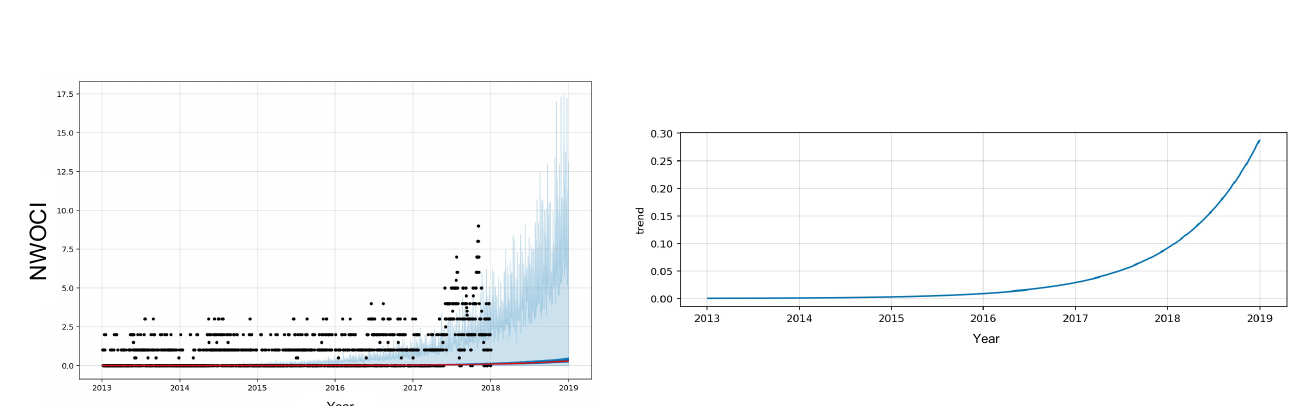
Figure A8. Left : One year forecast (2018 test data) from Prophet-BU Model for Hampden county in MA. N.B: The solid blue line shows the average forecast while the solid red line shows the observed trend of NWOCI and the light blue region represents the 80% confidence interval for the forecast uncertainty. Also, the scatter points represent the historical values in the training data (2013–2017). Right : Corresponding trend decomposition from Prophet-BU Model.